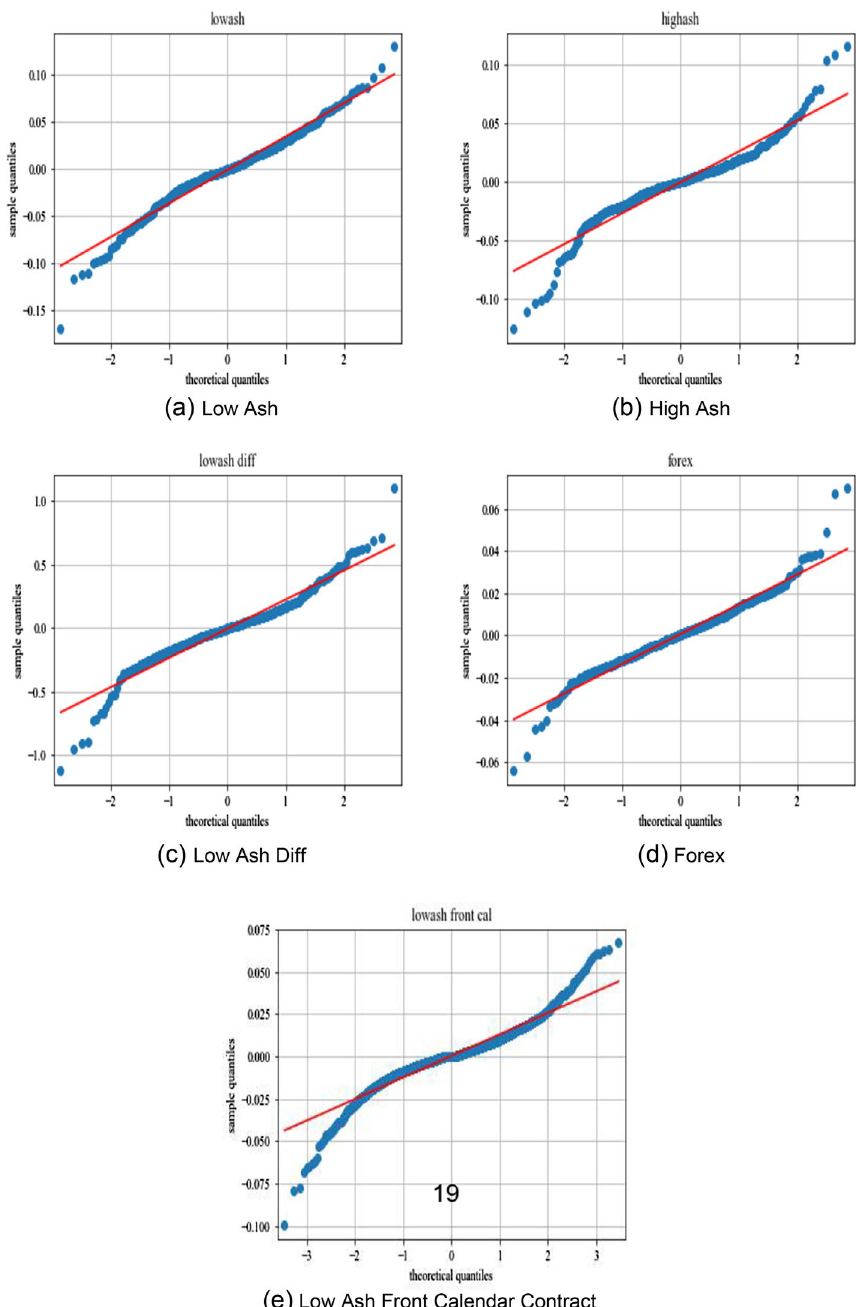
0.65, α 2 1.4, α 3 0.25 . 11 Next, in Fig. 6 we investigate the effect of the we chose α 1 = = = correlation between the forward prices and the instantaneous stochastic volatility, and these correlation have impacts on option prices. Finally, in Fig. 7 we show the distribu- tion of the Monte Carlo payoff for the spread option. As the time to expiry increases the payoff becomes asymptotically normal